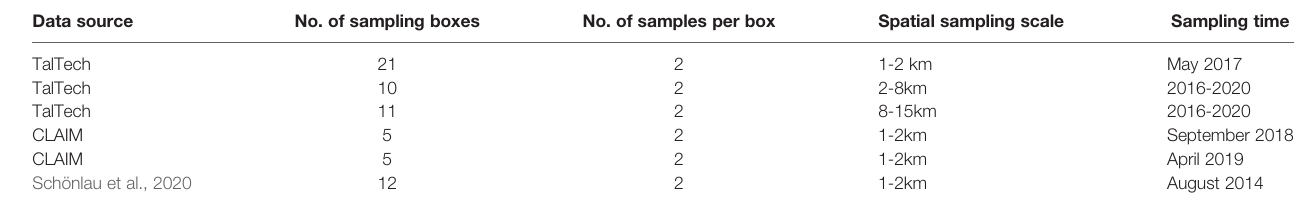
TABLE 1 | Microplastic datasets used in sampling error